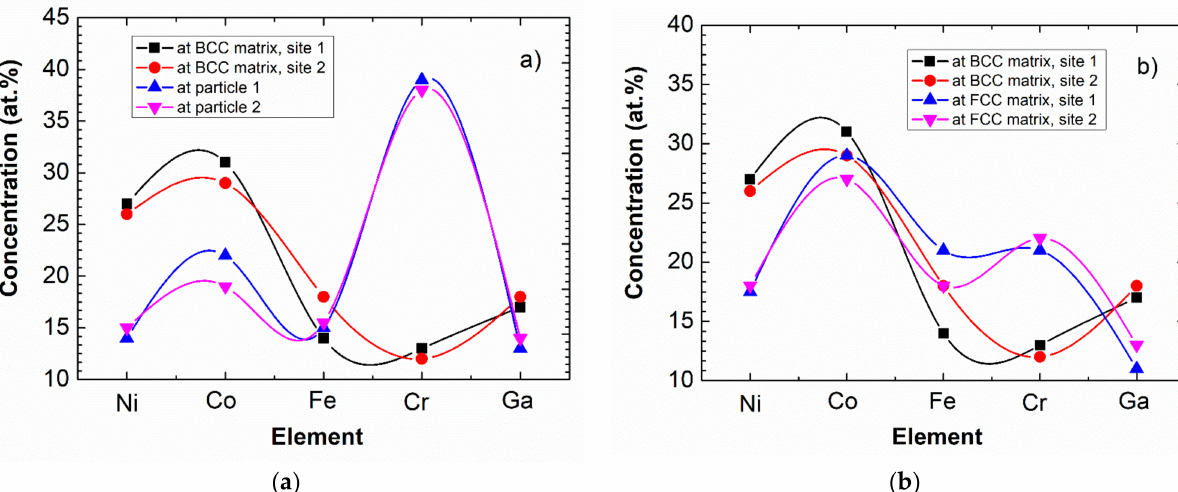
Figure 9. Composition of cuboidal particles and the surrounding BCC matrix ( a ), as well as that of BCC matrix and FCC phase ( b ). The data determined by ES having a relative error of about 5%. Note that the connecting lines are only indicating the elements belonging to the same measured points for easier clarity.